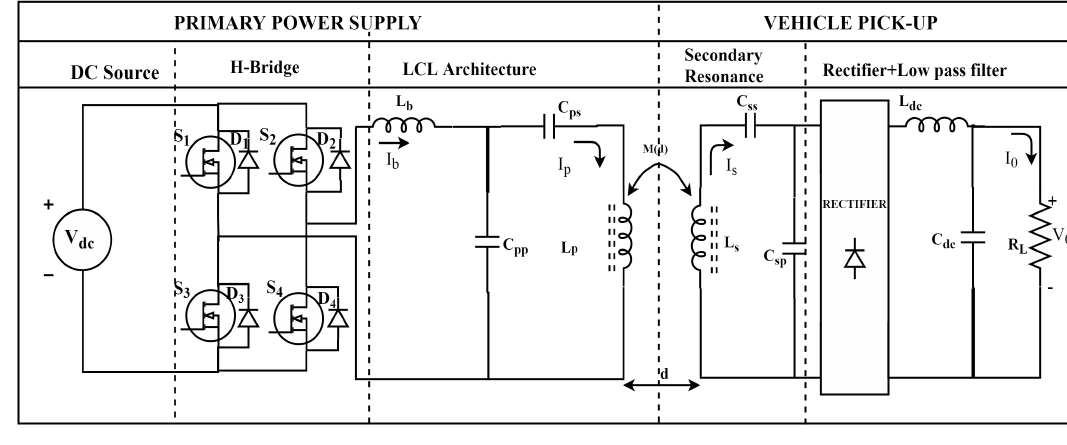
Figure 1. LCL based IPT system.